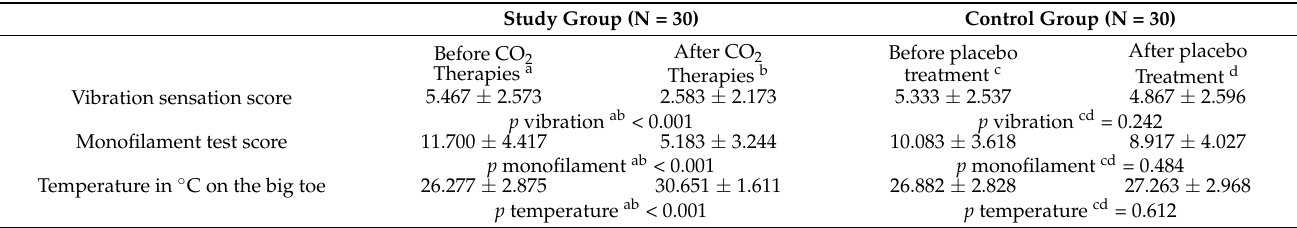
Table 2. Vibration sensation, monofilament test and temperature of the big toe before and after treatment in both legs for the study and control groups ( a study group before therapy, b study group after therapy, c control group before therapy, d control group after